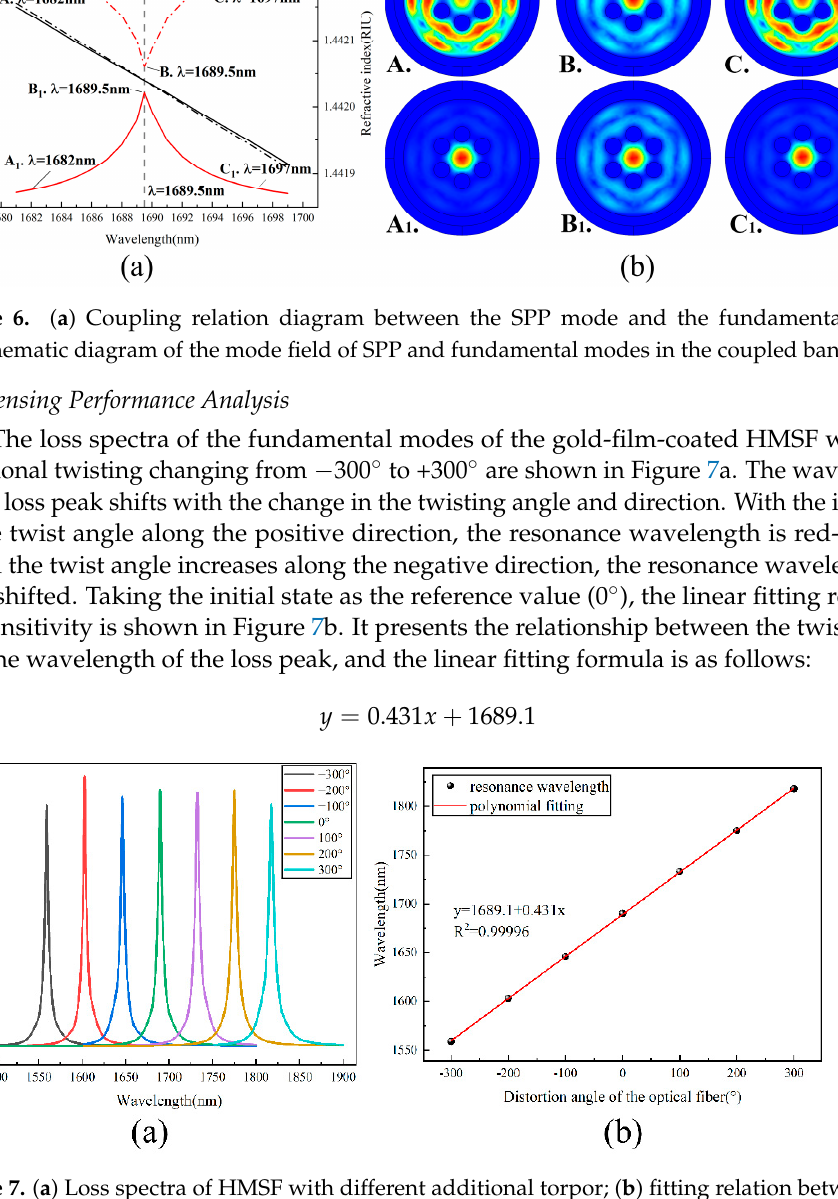
resonance wavelength and the additional torsion angle.